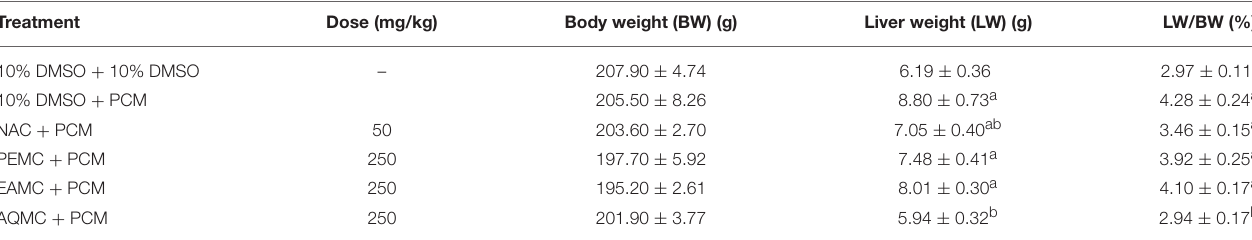
TABLE 2 | Effect of PEMC, EAMC, or AQMC, at the dose of 250 mg/kg, on the body and liver weights, and liver/body weight ratio following the oral administration of paracetamol (PCM) in rats. Treatment Dose (mg/kg)